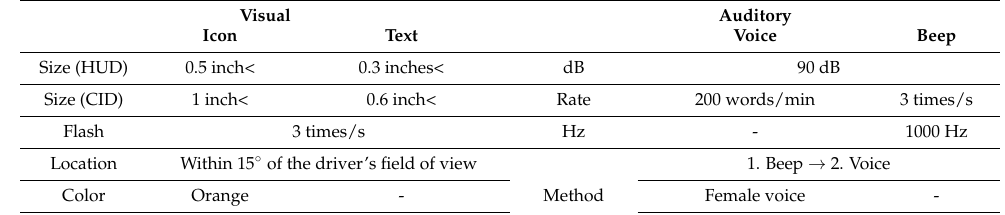
Table 2. Alarm method for distracted drivers.